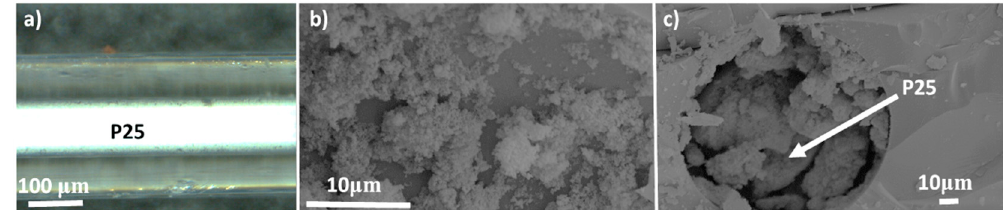
Figure 2. Microscopy images of the capillary sample Cap. 25 prepared in this study ( a ). ( b , c ) present the SEM images of the P25 inside the microcapillary for the same sample.